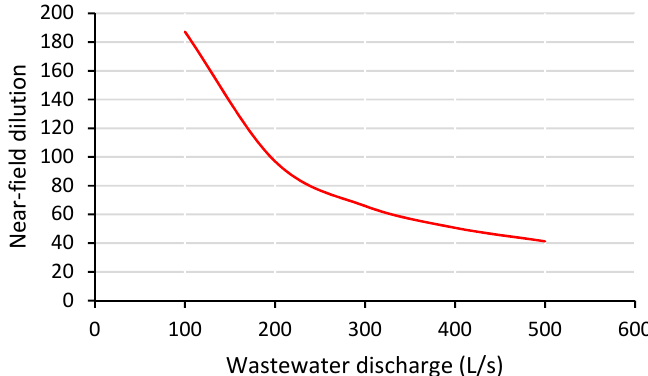
Figure 12. The effect of wastewater discharge on near-field dilution [20].